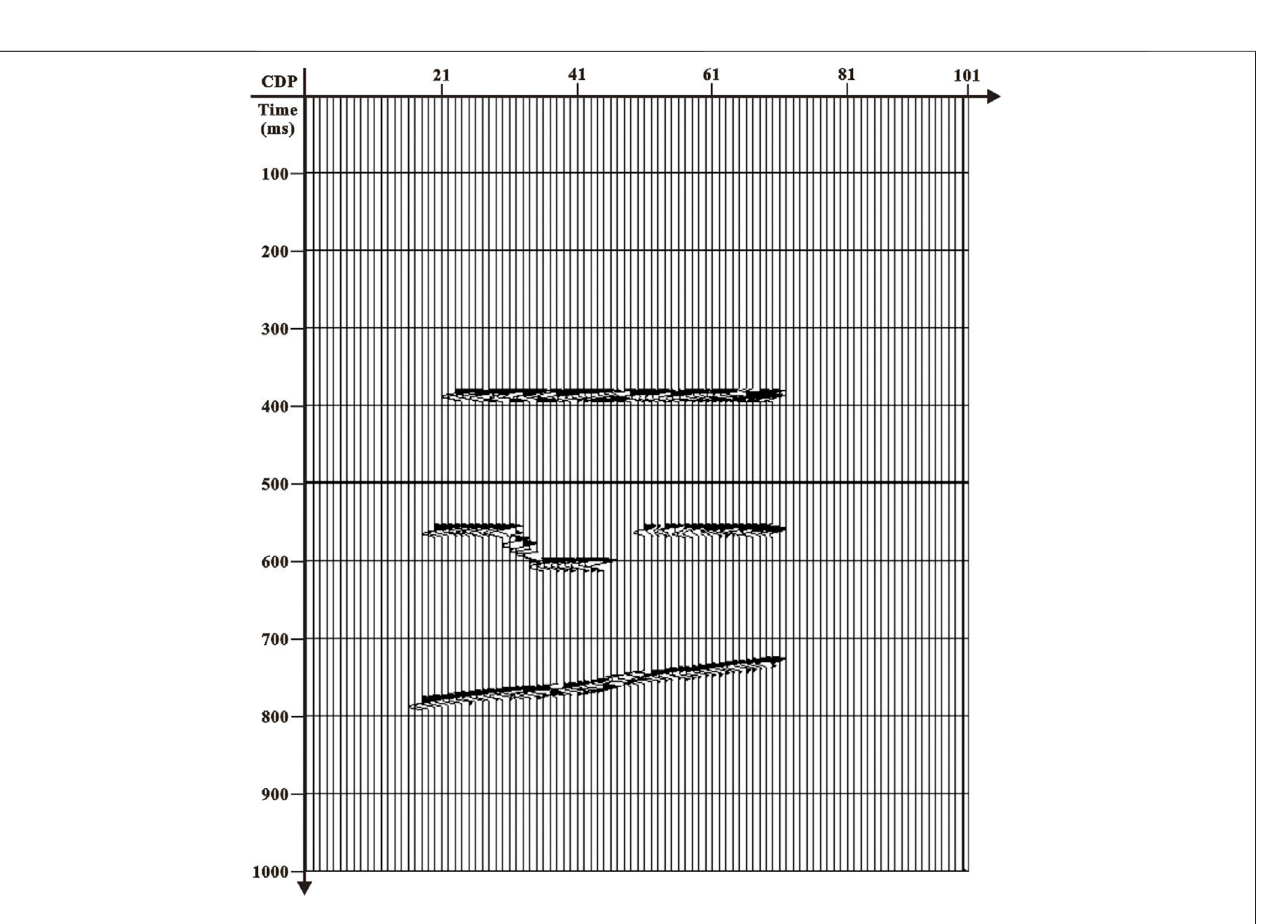
Frontiers in Earth Science |